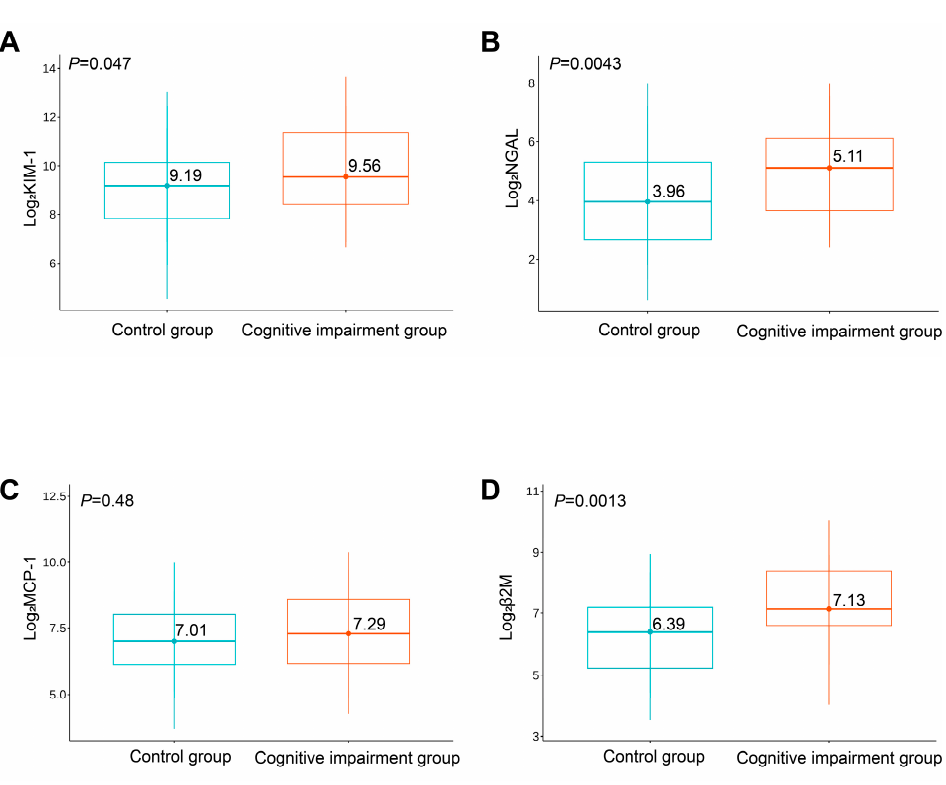
Figure 1. Expression levels of log2KIM-1 ( A ), log2NGAL ( B ), log2MCP-1 ( C ), and log2 β 2M ( D ) between the two groups of study participants.